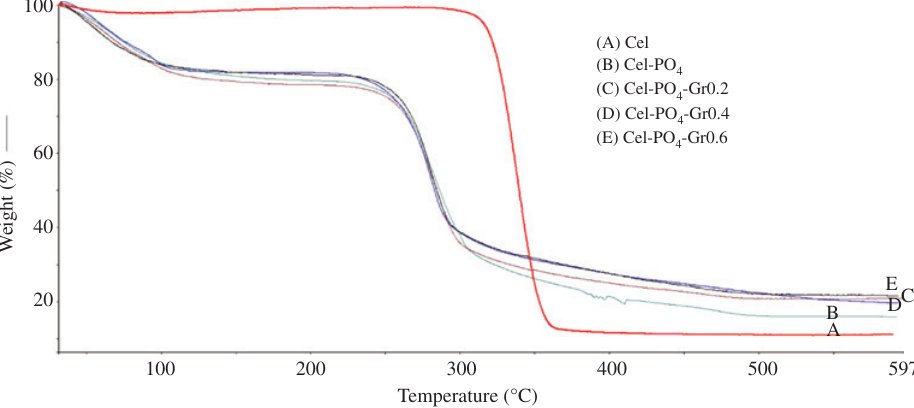
, (B) Cel-PO -Gr0.2, (C) Cel-PO 4 4